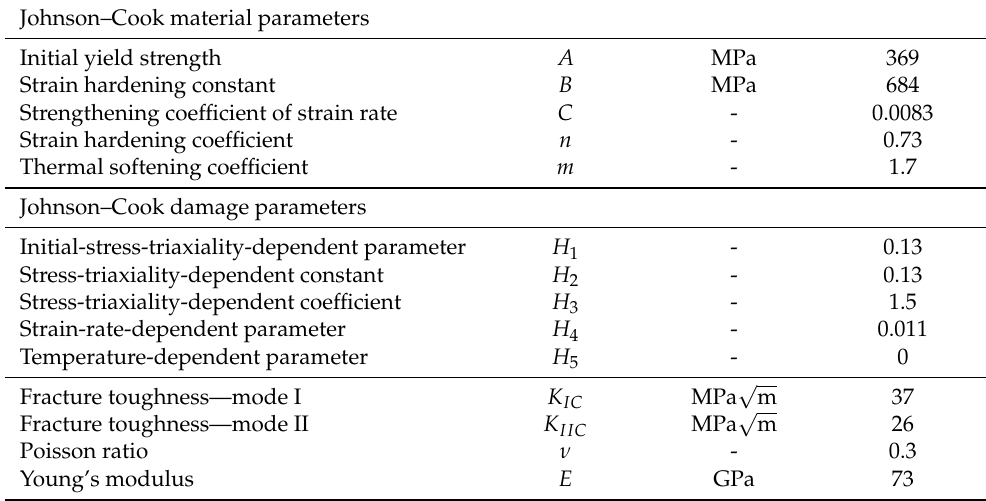
Table 1. Johnson–Cook material parameters, damage coefficients, and fracture toughness properties of A2024-T351, taken from